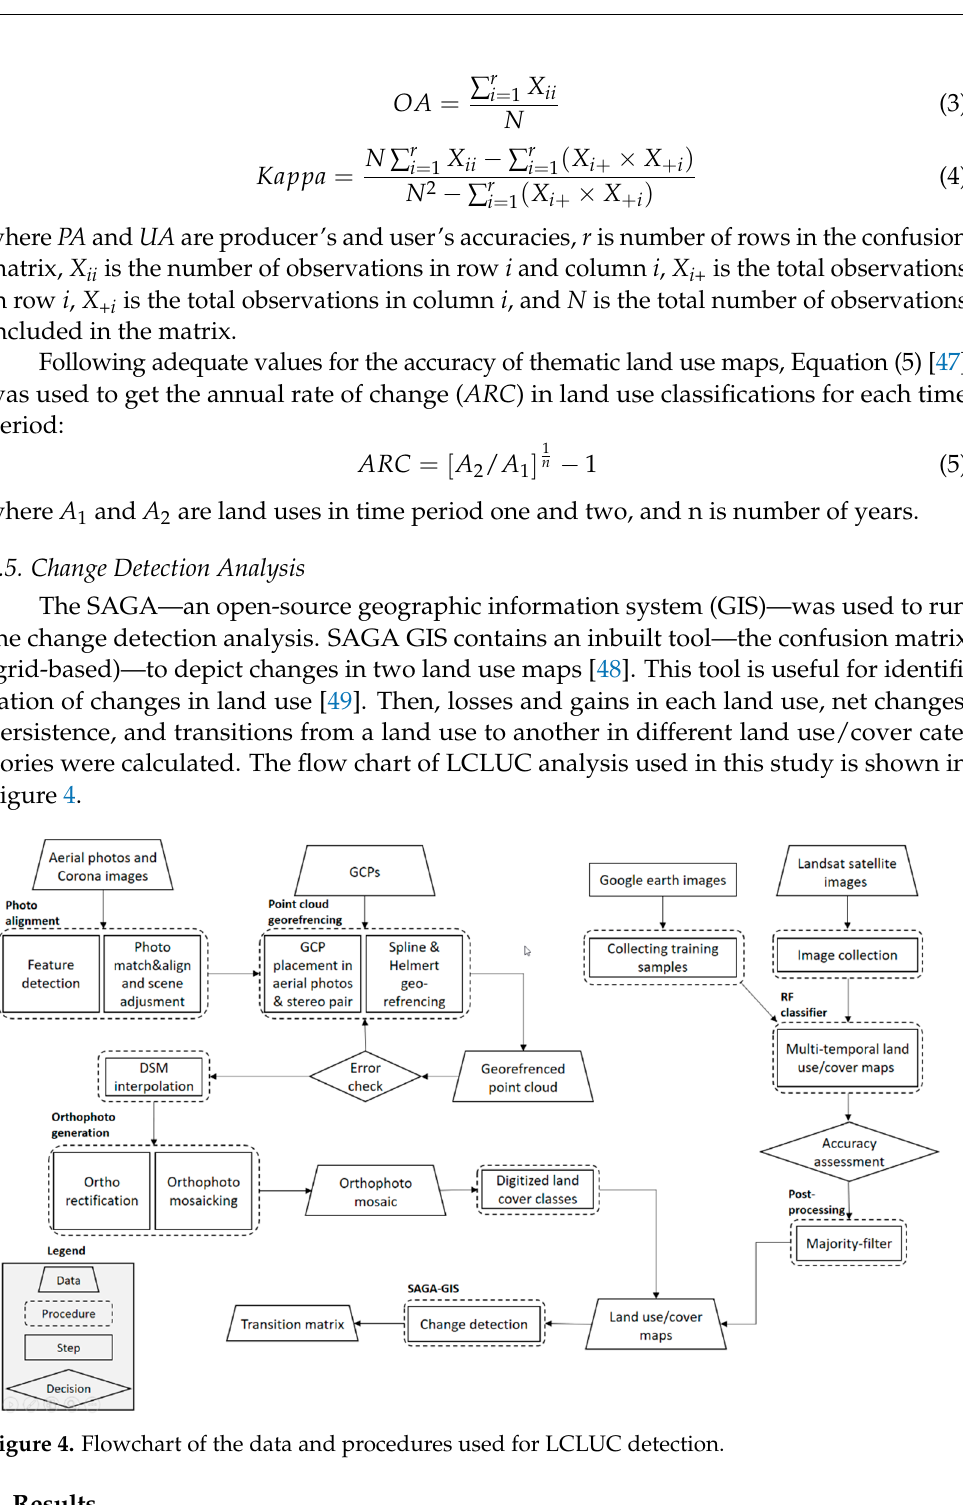
Table 3. Image classification accuracy evaluation for the studied years.